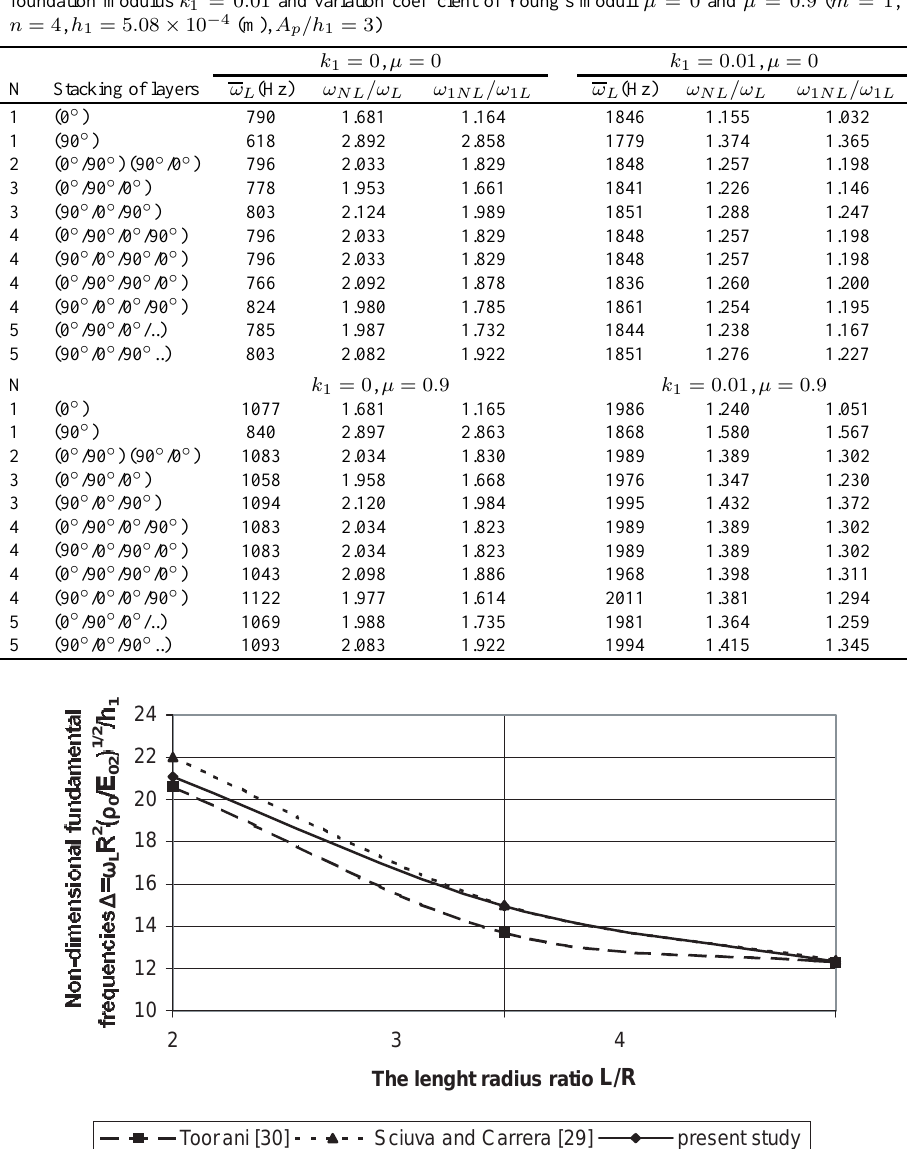
Table 5 Variationofthenaturalandrelativefrequencieswithrespecttonumberandorderingoflayersfornon-dimensional